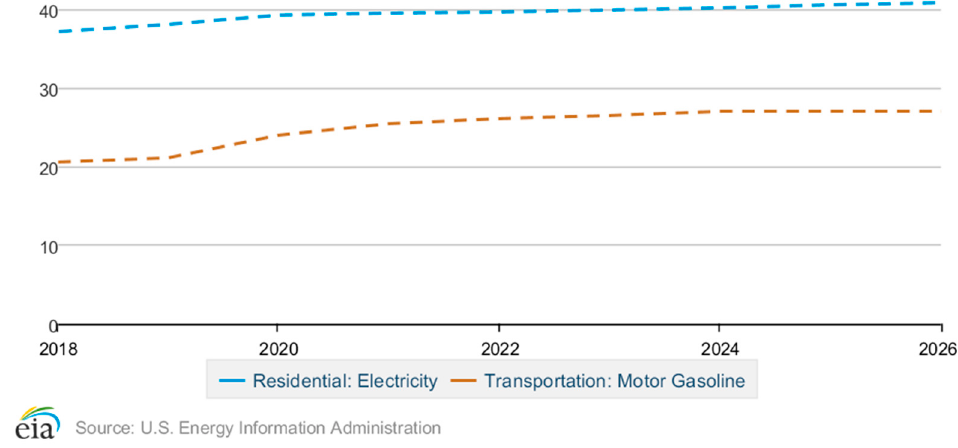
Figure 4. Energy price forecasts from the U.S. Energy Information Administration in $/MMBtu.